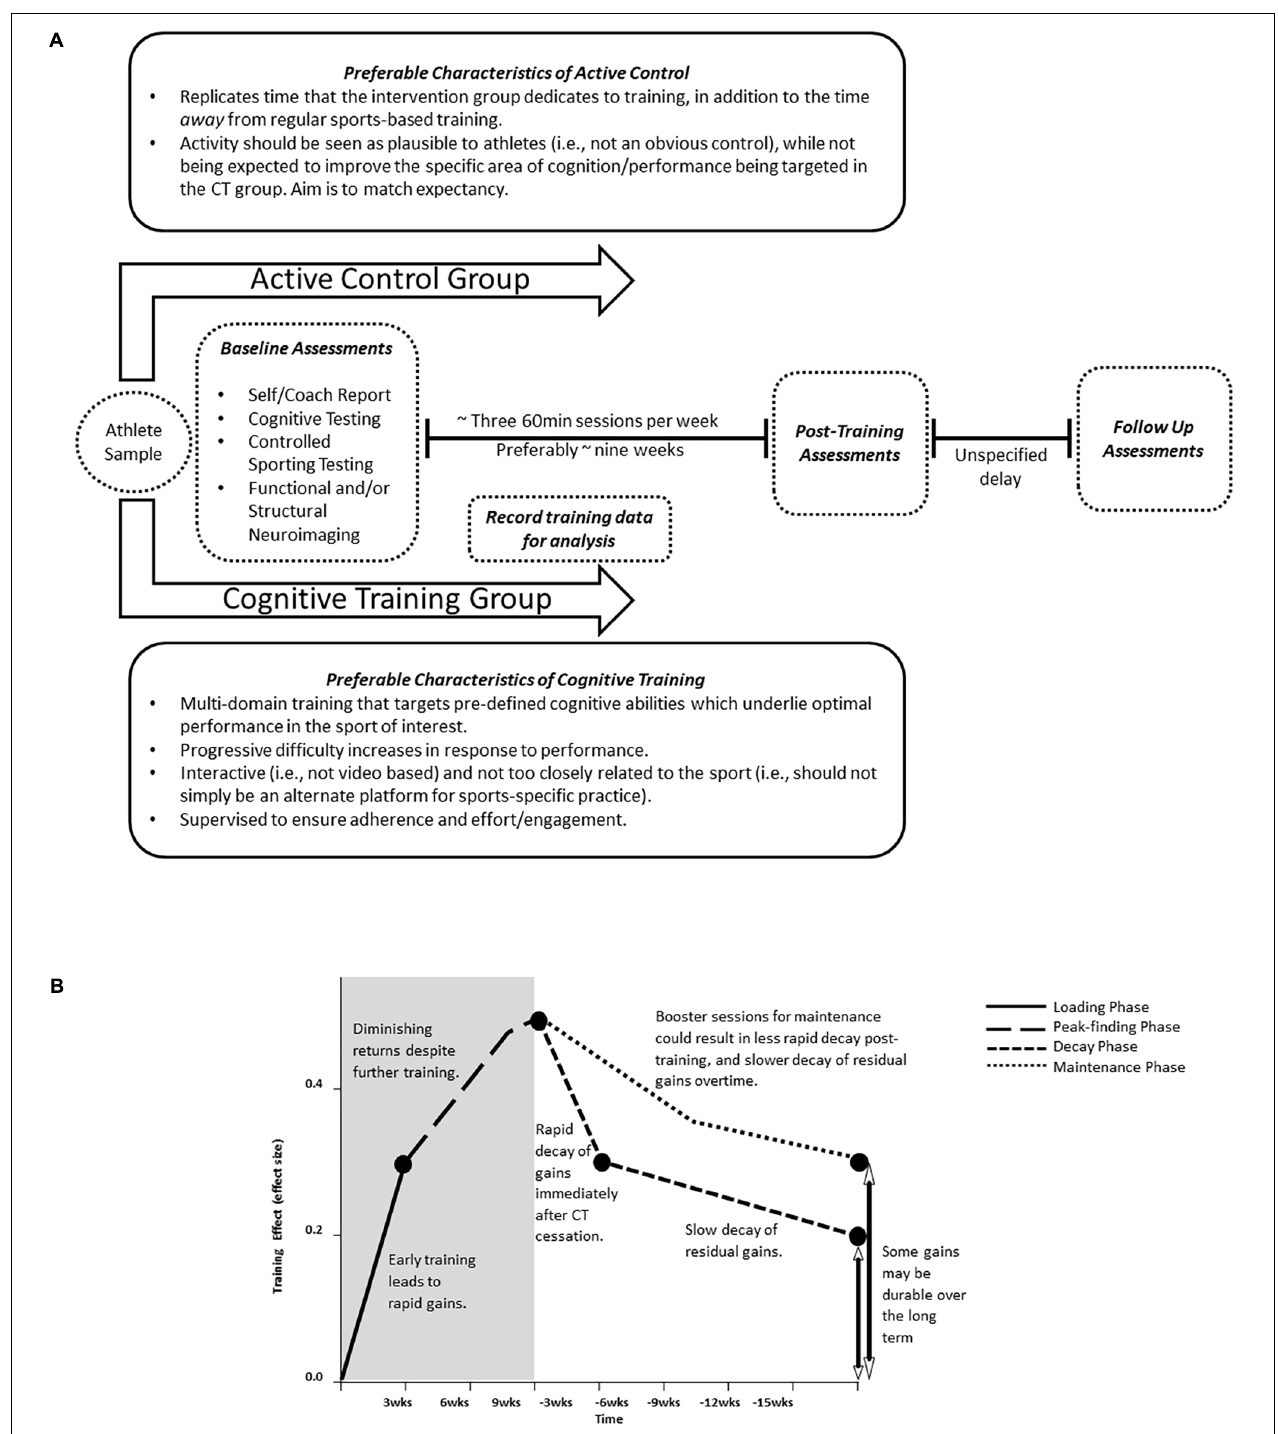
FIGURE 1 | (A) Example RCT design to asses CT for athletes. Brief outline of the preferable characteristics of the training and control groups, duration and frequency of the intervention and the types of assessments that should be administered. (B) Assumed therapeutic effect of CT overtime. Training (gray) initially produces rapid gains during the loading phase, which then begin to plateau during the peak-fining phase. Once training is ceased (white), during the decay phase, gains decay rapidly and then gradually over time. However, if a maintenance phase comprising of booster sessions is implemented during the decay phase, then gains may be durable over a longer period of time. In any case, training will result in a higher level of cognition when compared to baseline. Image adapted from Figure 3 in Lampit et al. (2014a).